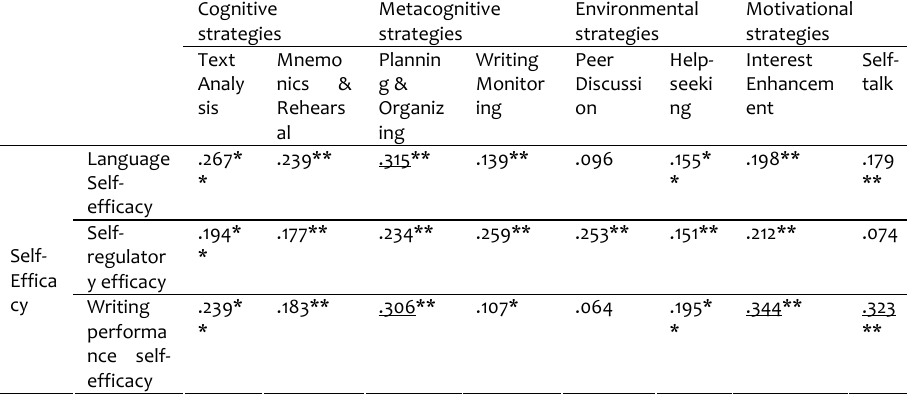
Table 5. Correlations of Self-regulatory Strategies with Self-efficacy (N =